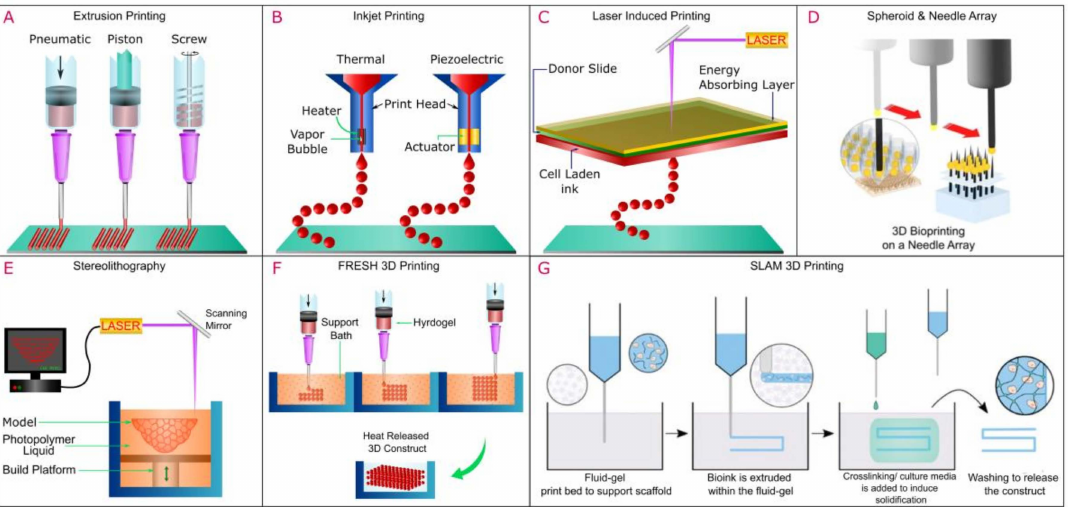
Figure 4. Modalities of 3D Bioprinting ( A ) Extrusion based printing ( B ) Inkjet Printing ( C ) Laser Induced Printing ( D ) Kanzen Spheroid and needle array ( E ) Stereolithography ( F ) FRESH 3D printing method ( G ) SLAM 3D Printing. ( D ) reproduced under the terms and conditions of the